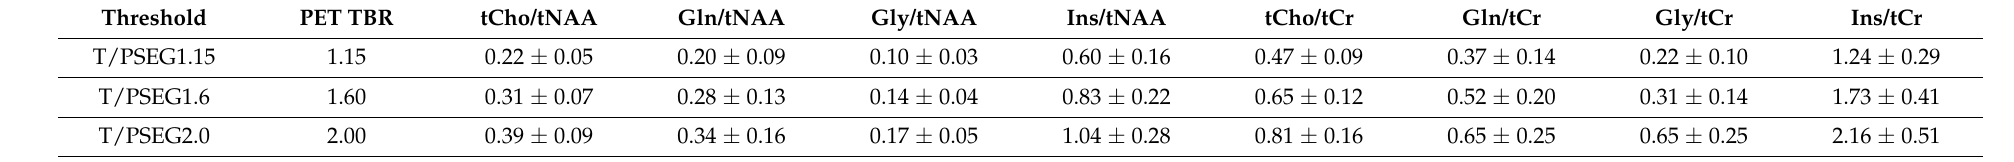
Table 7. Explicit VOI thresholds for all ratios and VOI threshold